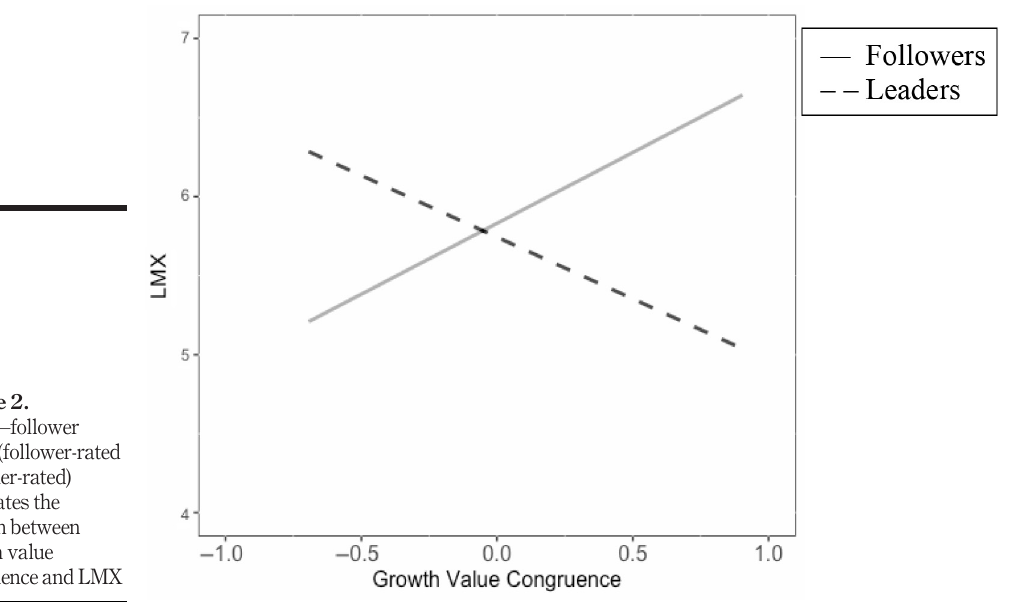
values resulting in worse performance in the presence of low LMX. This hypothesis was not supported ( b = (cid:1) 0.04, SE = 0.08, p = 0.59). H3b states that valuing status moderates the LMX – performance relationship, with high-status values resulting in worse performance in the presence of low LMX. This hypothesis was supported ( b = 0.13, SE = 0.06, p = 0.02), with individuals high in status values exhibiting weaker LMX – performance relationships than those low in status values (Figure 3).